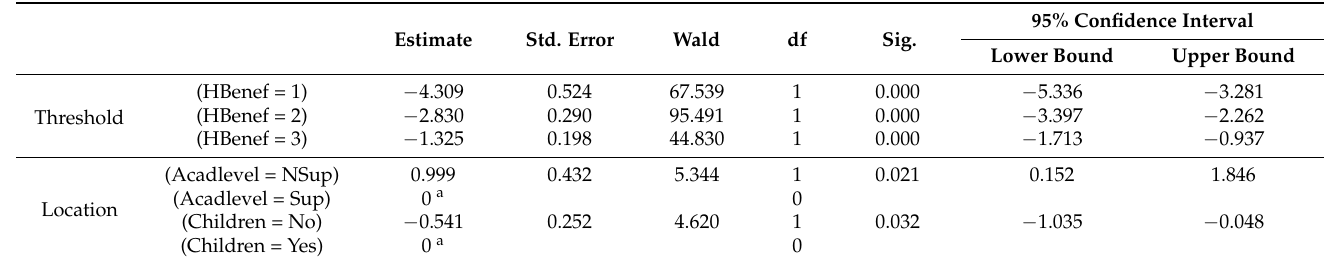
Table 7. Parameter